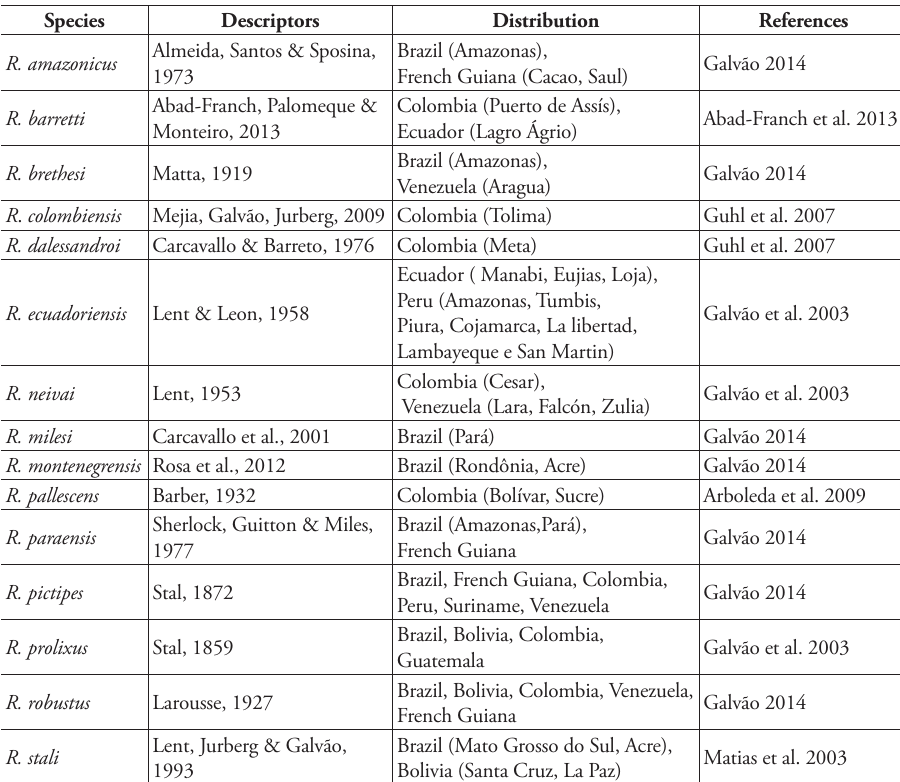
Table 3. Triatominae species found in the Amazon